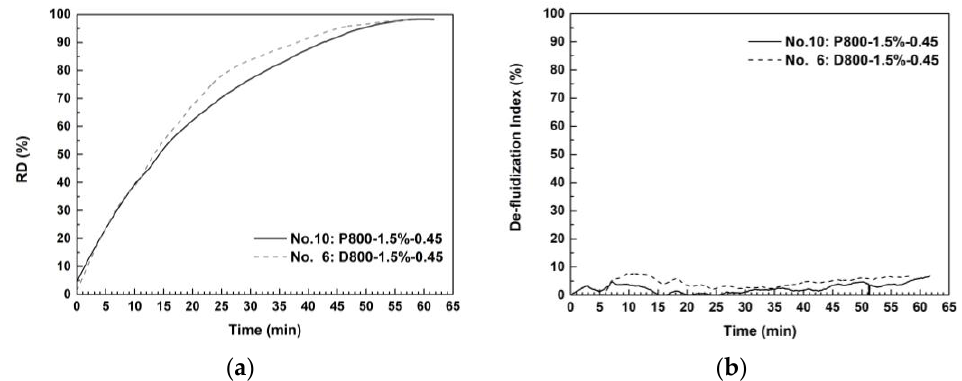
Figure 2. The fluidized reduction results of experiments No.6 and No. 10: ( a ) reduction curve; ( b ) de-fluidization curve. P800-1.5%-0.45 represents that the magnetite iron ore was partly oxidized at 800 °C, mixed with 1.5 wt.% of MgO and reduced in the fluidized bed at a gas velocity of 0.45 m/s; D800-1.5%-0.45 represents that the magnetite iron ore was deeply oxidized at 800 °C, mixed with 1.5 wt.% of MgO and being reduced in the fluidized bed at a gas velocity of 0.45 m/s.